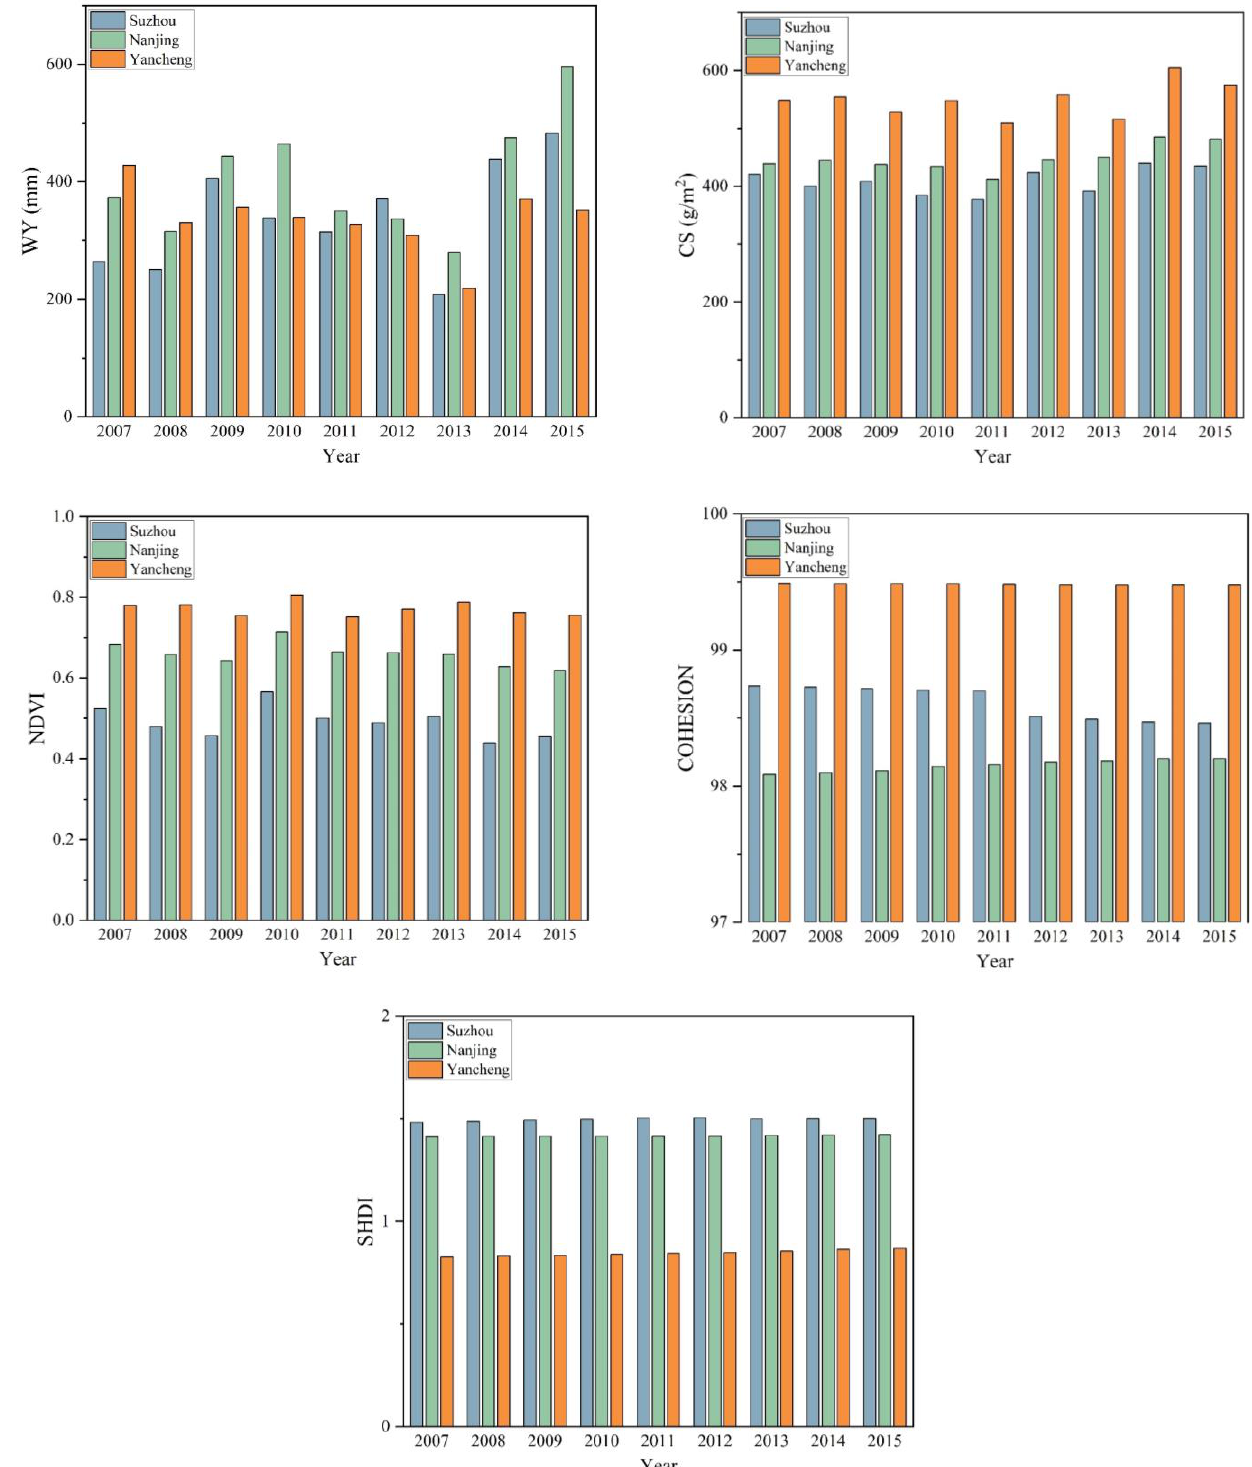
Figure 3. Temporal variation in the five ecosystem services.